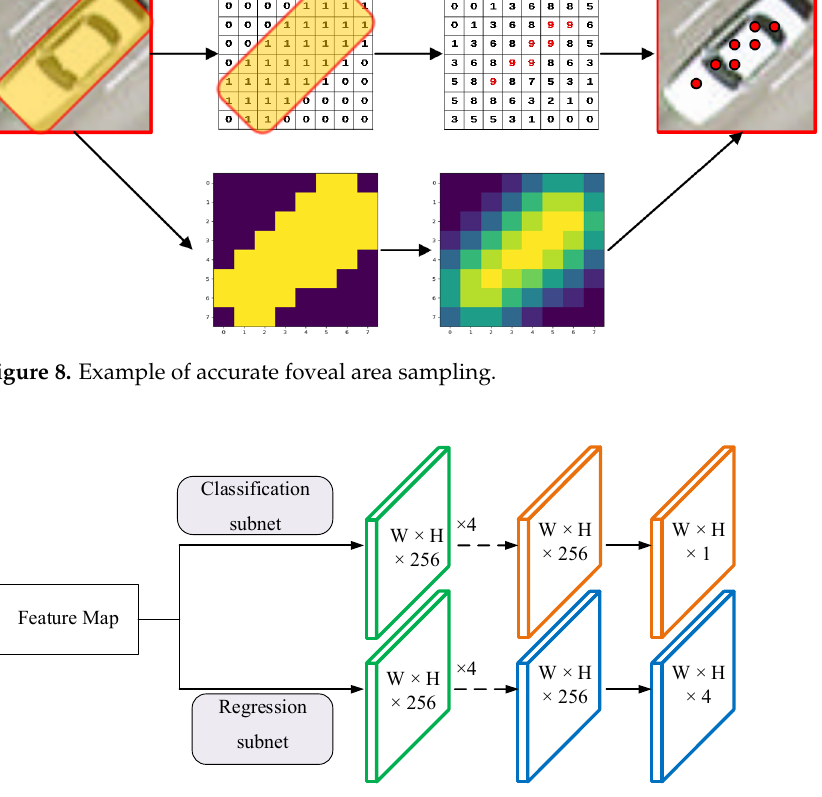
Figure 9. Prediction network. (a) Classification subnet(top), (b)Regression subnet(bottom).